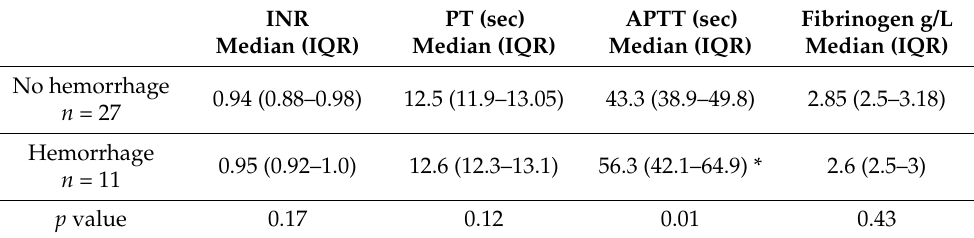
Table 7. Association of hemorrhage during defervescence with conventional coagulation profile (UKMMC subjects, n =